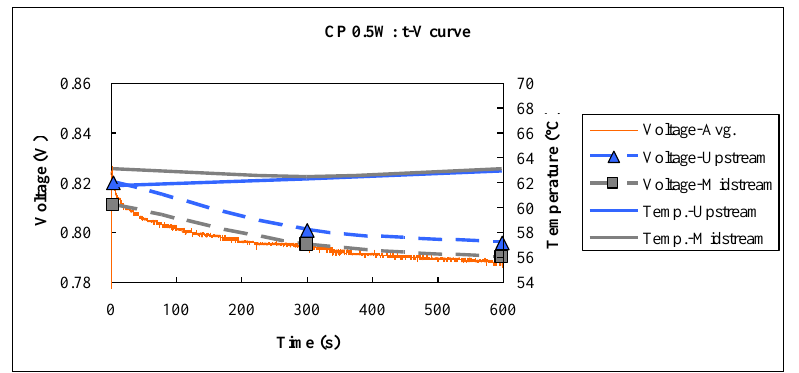
Figure 14. Voltage and temperature difference at constant power 0.5 W. CP 0.5W: t-V